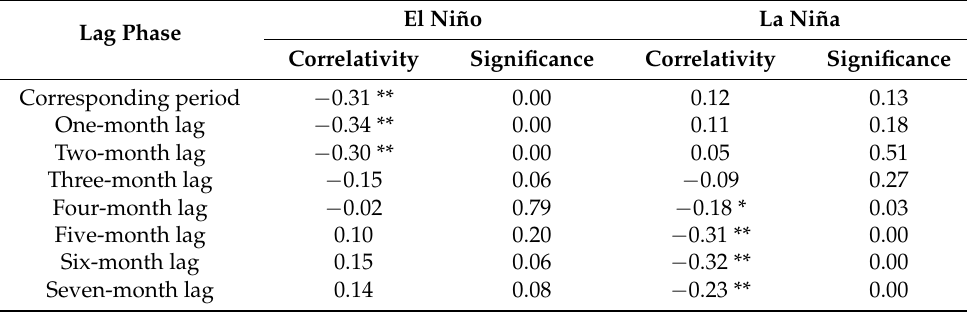
Table 3. Correlation between climatic erosivity and SST in ENSO years. El Niño La Niña Lag Phase Correlativity Significance Correlativity Significance Corresponding period − 0.31 ** 0.00 0.12 0.13 One-month lag − 0.34 ** 0.00 0.11 0.18 Two-month lag − 0.30 ** 0.00 0.05 0.51 Three-month lag Four-month lag − 0.02 0.79 − 0.18 * 0.03 Five-month lag 0.10 0.20 − 0.31 ** 0.00 Six-month lag 0.15 0.06 − 0.32 ** 0.00 Seven-month lag 0.14